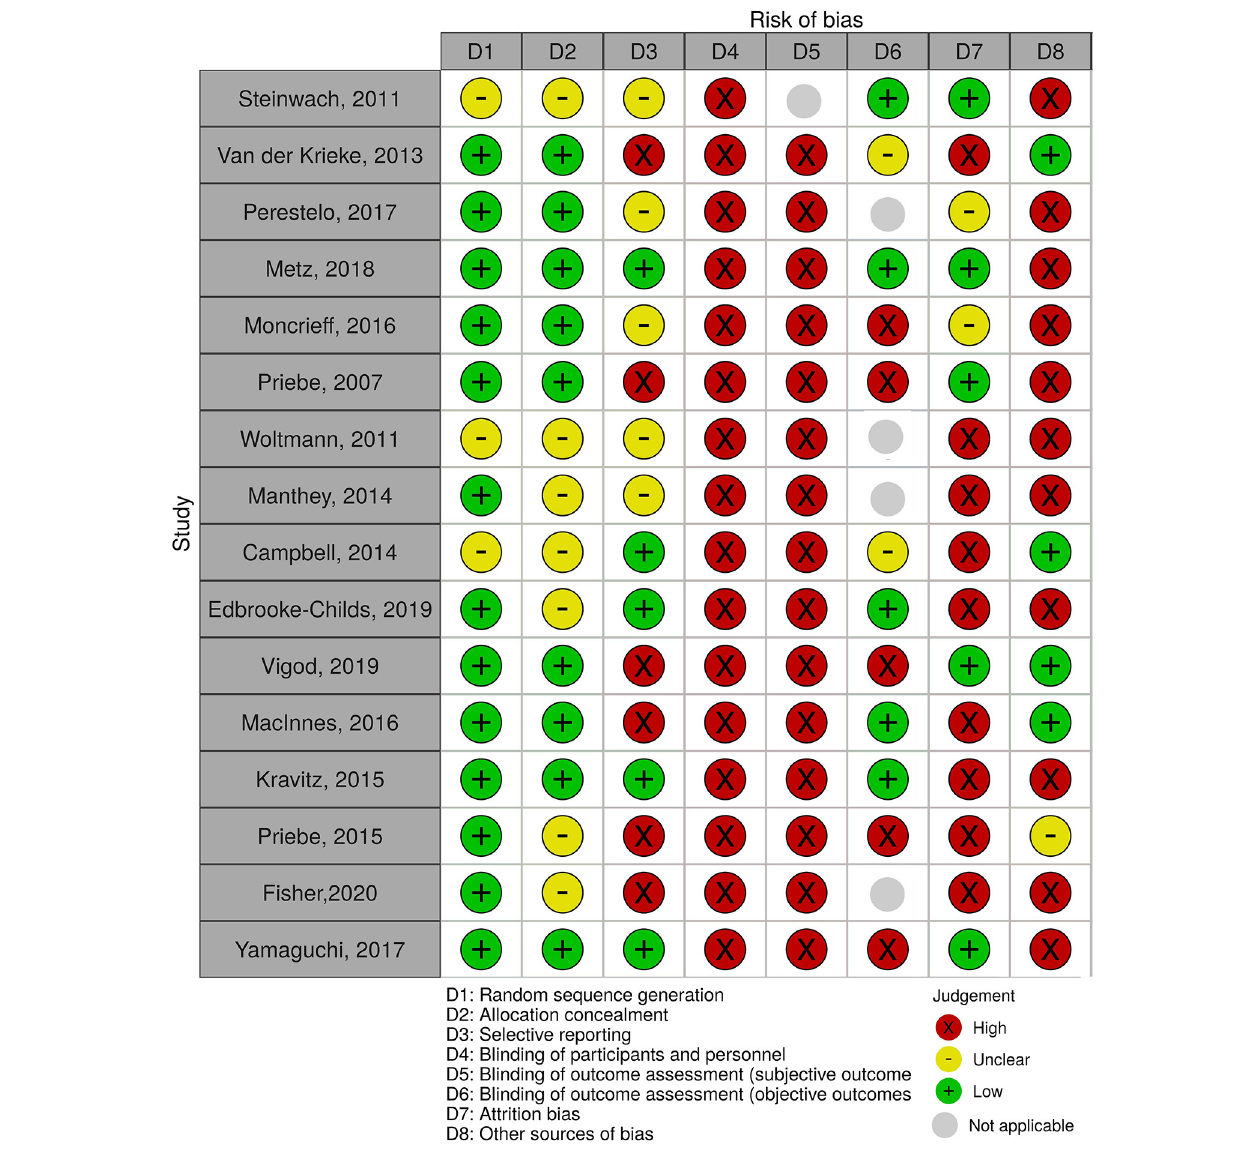
FIGURE 2 | Risk of bias of the 16